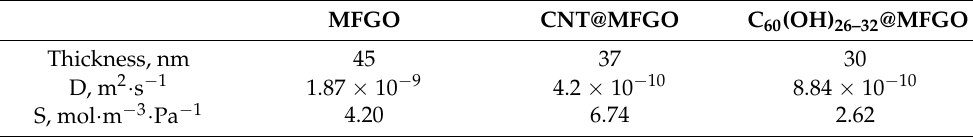
Table 3. Diffusion and sorption coefficients of the composite membranes (at T = 23 ◦ C, RH = 60%).